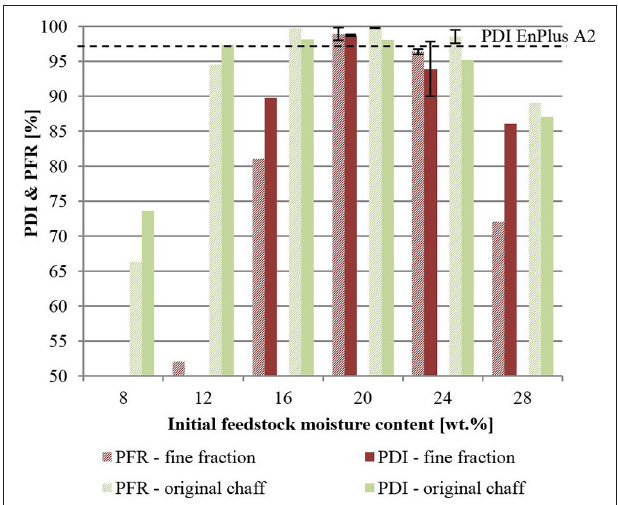
FIGURE 4 | Pellet durability index (PDI) and pellet formation rate (PFR) for wheat chaff pellets of fine fraction chaff and original chaff at different moisture contents (l/d =